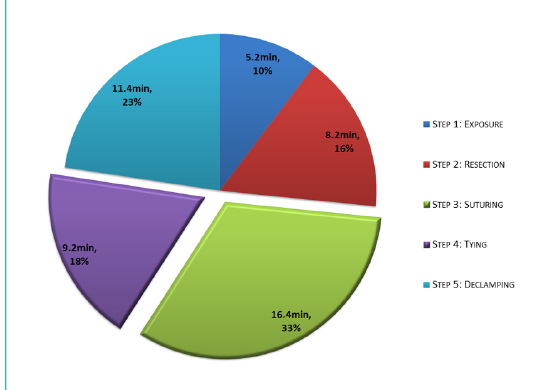
Figure 3: Distribution of the five steps of aortic cross-clamp time.